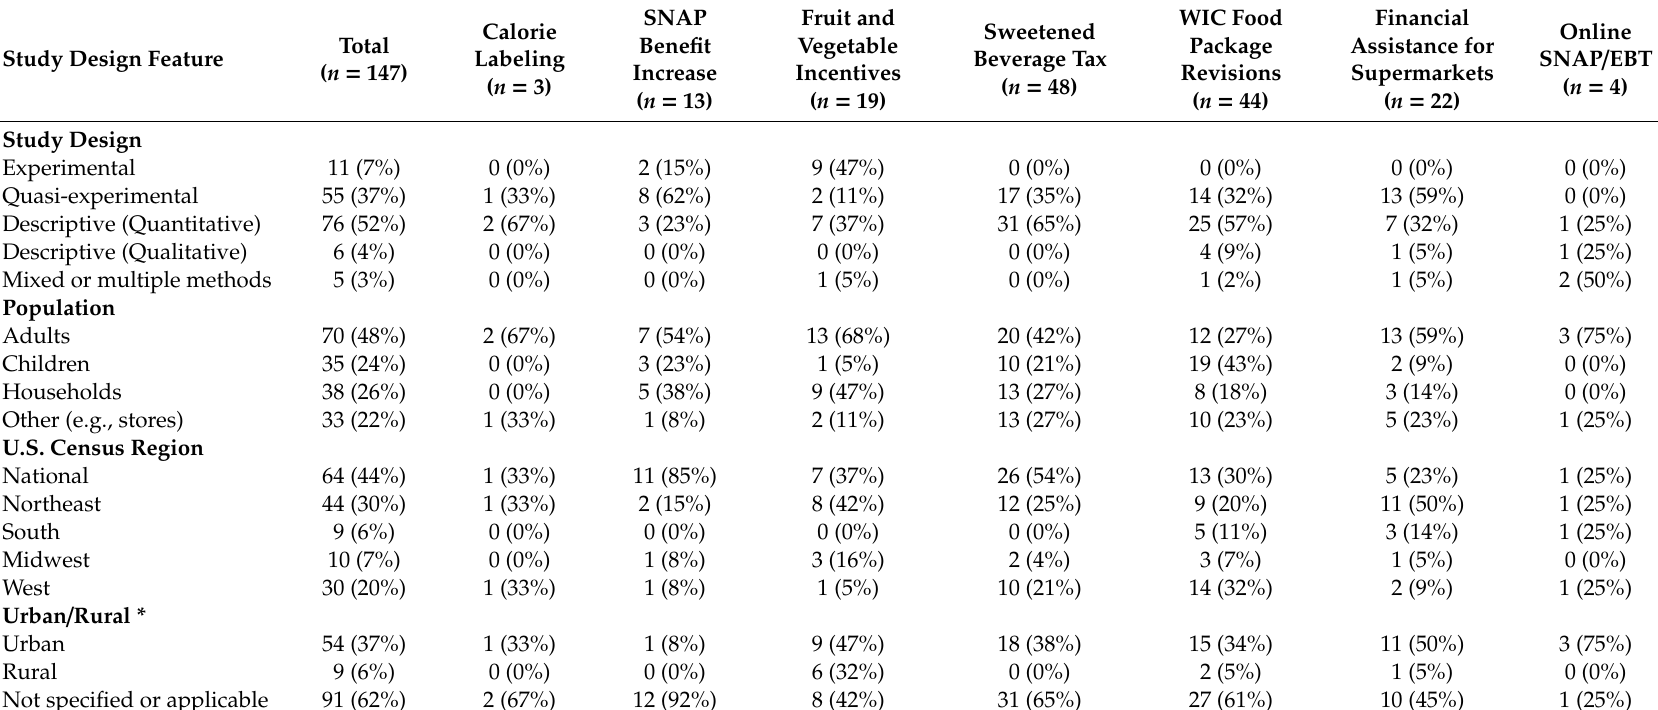
Table 2. Study design features of included articles, by policy action